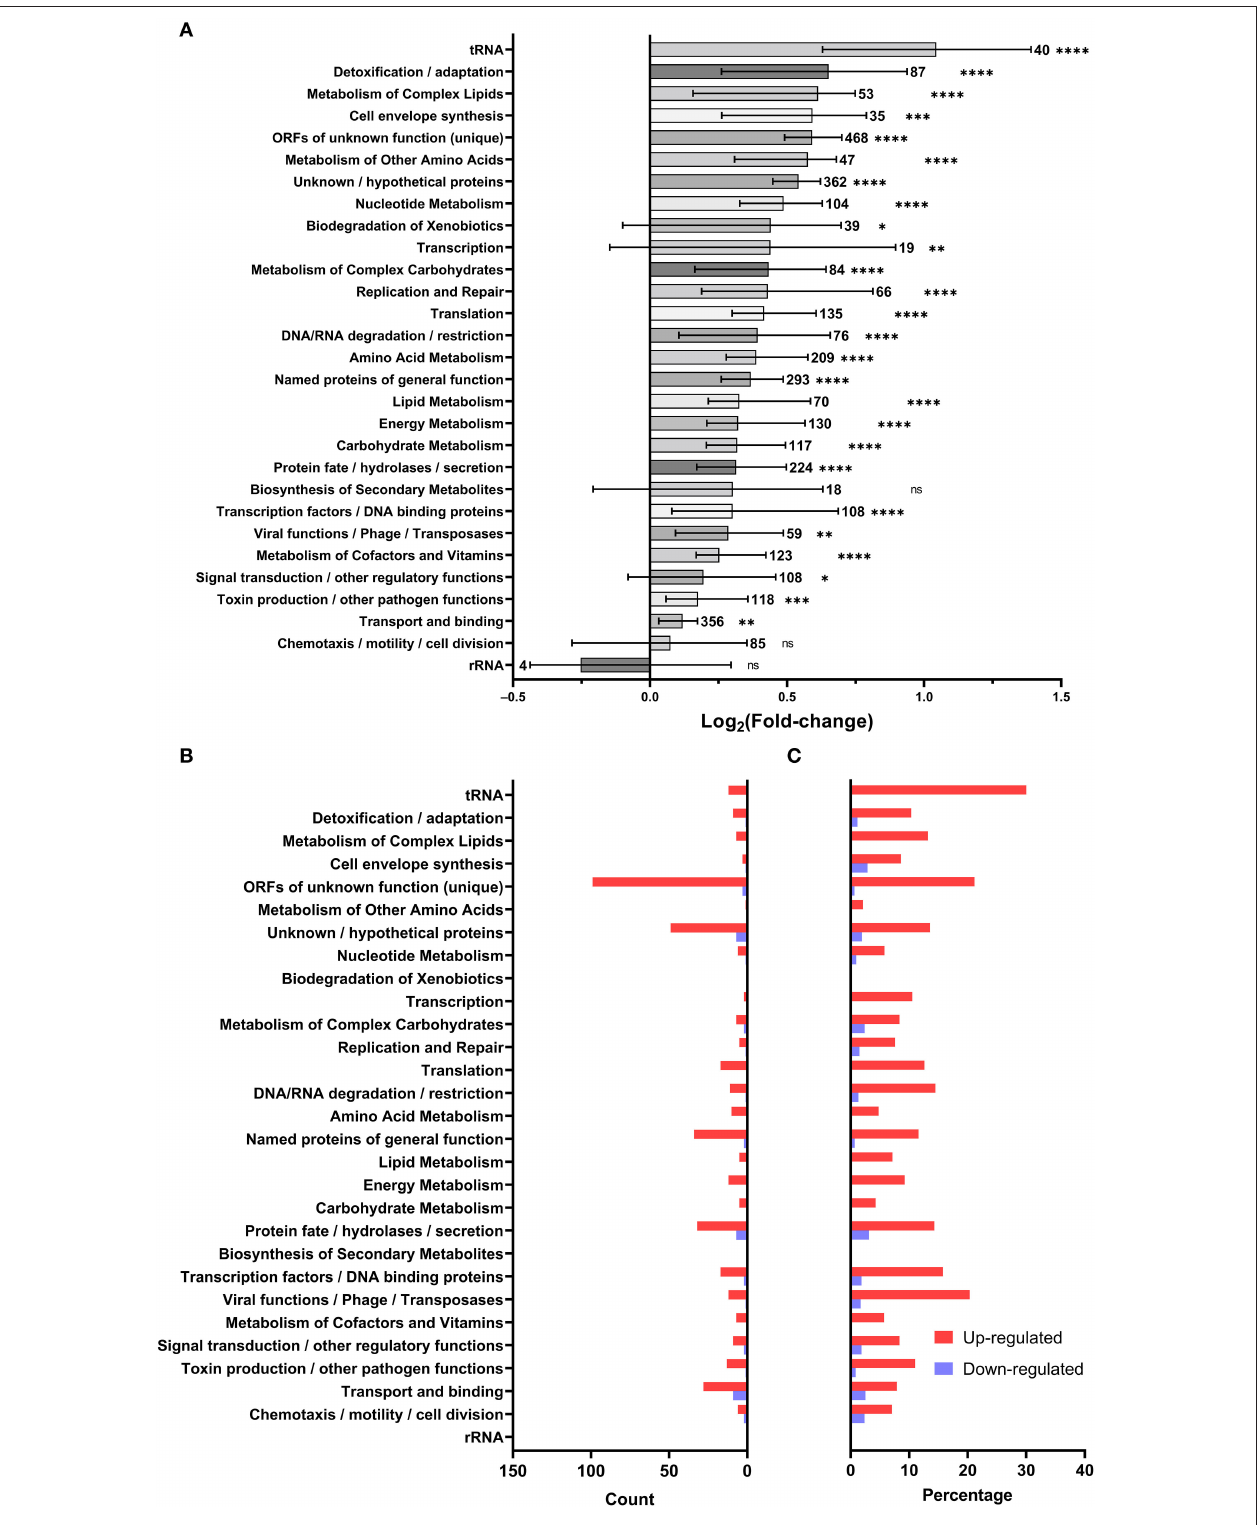
FIGURE 3 | Microarray data summarized by GenBank annotated function. Each gene was assigned to the GenBank categories included in its annotated function: (A) the distribution of log 2 fold-change of genes included in each category (bars and error bars show mean and 95% confidence interval; sample size adjacent to each bar; a one-sample two-tailed Wilcoxon signed rank test in Prism 9.3.1 was used to evaluate the significance of discrepancy between the observed log 2 fold-changes and a hypothetical log 2 fold-change of 0; ns = not significant, * < 0.05, ** < 0.01, *** < 0.001, **** < 0.0001), (B) count of differentially regulated genes in each Genbank category, (C) percentage of genes differentially regulated in each Genbank category.